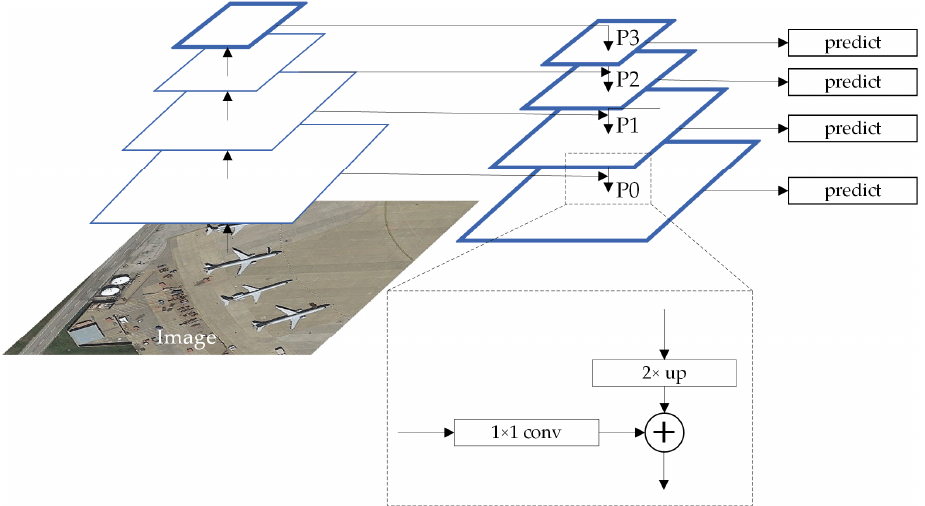
Figure 3. The FPN network structure diagram.